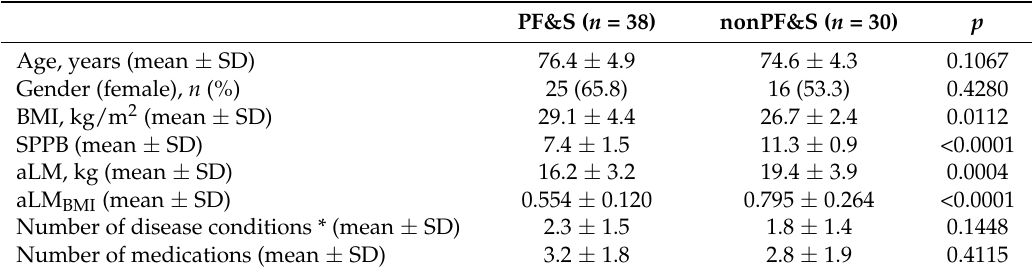
Table 1. Main characteristics of BIOmarkers associated with Sarcopenia and Physical frailty in